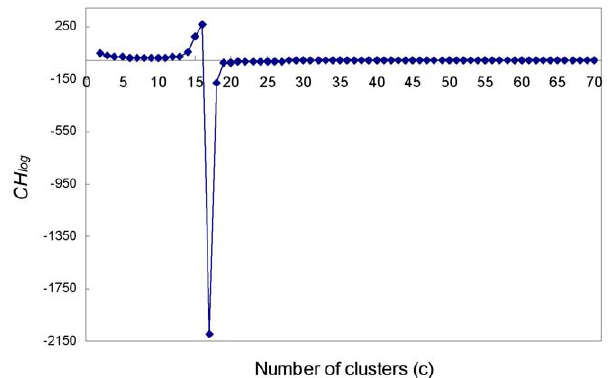
Figure 3. The CH log plot. The log modified Calinski and Harabasz metric ( CH log ) at different hierarchical levels (from 2 to 70 clusters) for the motif tree in Figure 2. The maximal CH log value was reached when the number of clusters ( c ) was 16, suggesting an optimal number of 16 groups of PFMs for the 71 non-ZF PFMs in Dataset-1.